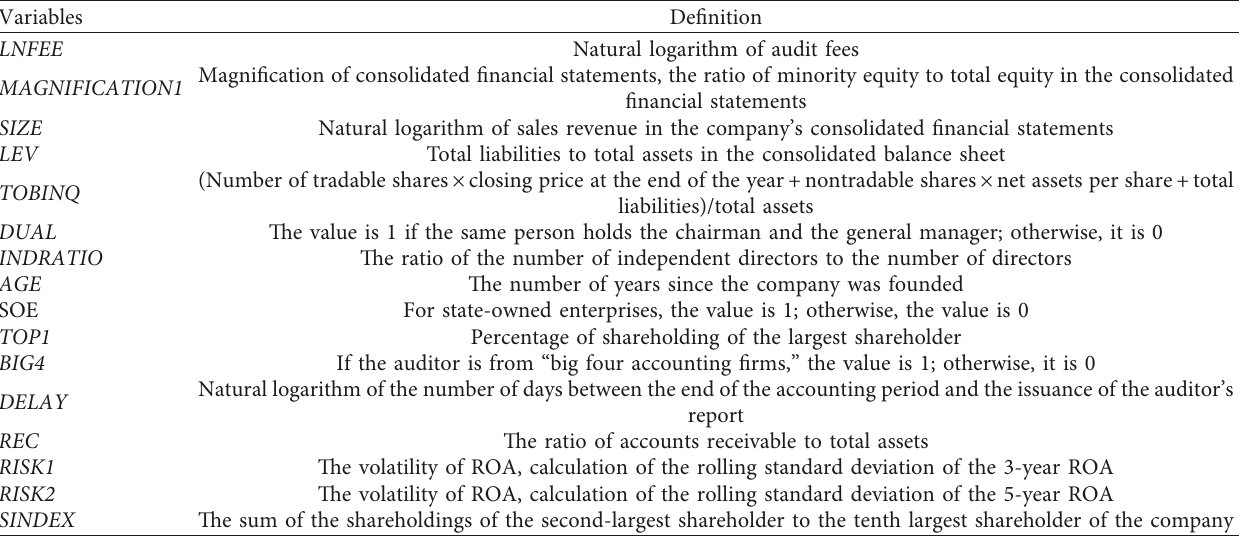
Table 3: Variable